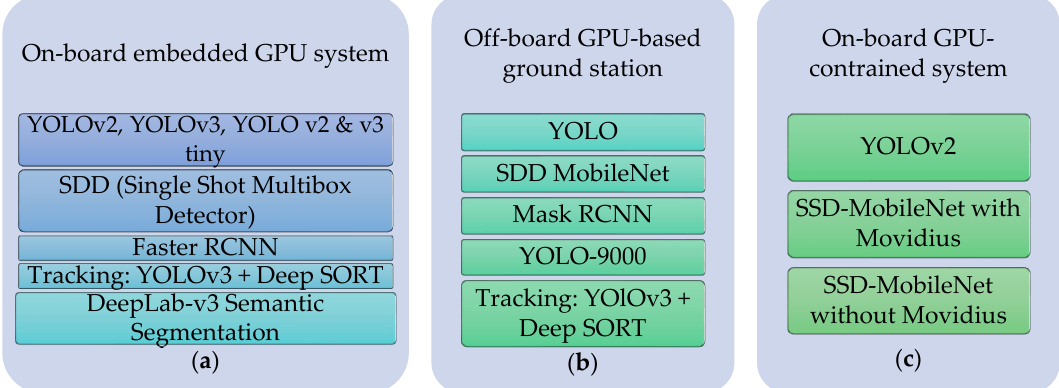
Figure 8. List of deep learning algorithms implemented in the aerial vehicle: ( a ) On-board embedded GPU system; ( b ) off-board GPU-based ground station; ( c ) on-board GPU-constrained system.